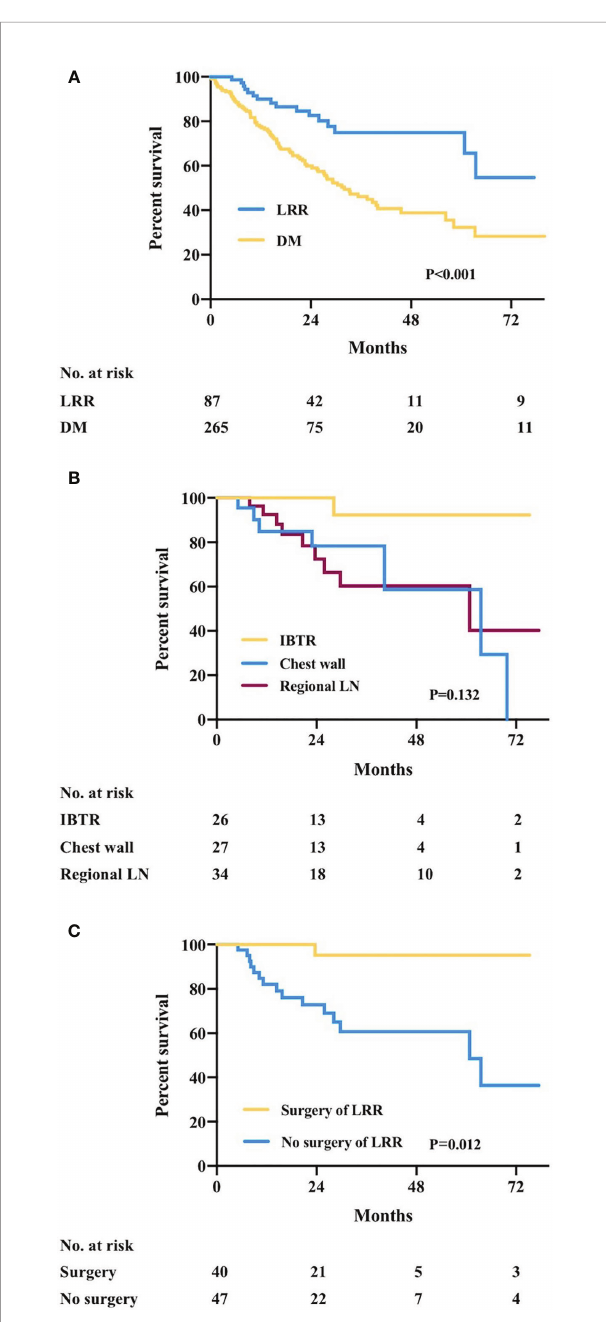
FIGURE 2 | Post-recurrence overall survival (PR-OS) by recurrence type. (A) PR-OS in recurrent patients by fi rst recurrence event. (B) PR-OS in LRR patients by LRR type. (C) PR-OS in LRR patients receiving or not salvage surgery for LRR. LRR, locoregional recurrence; DM, distant metastasis; No., number; IBTR, ipsilateral breast tumor recurrence; LN, lymph